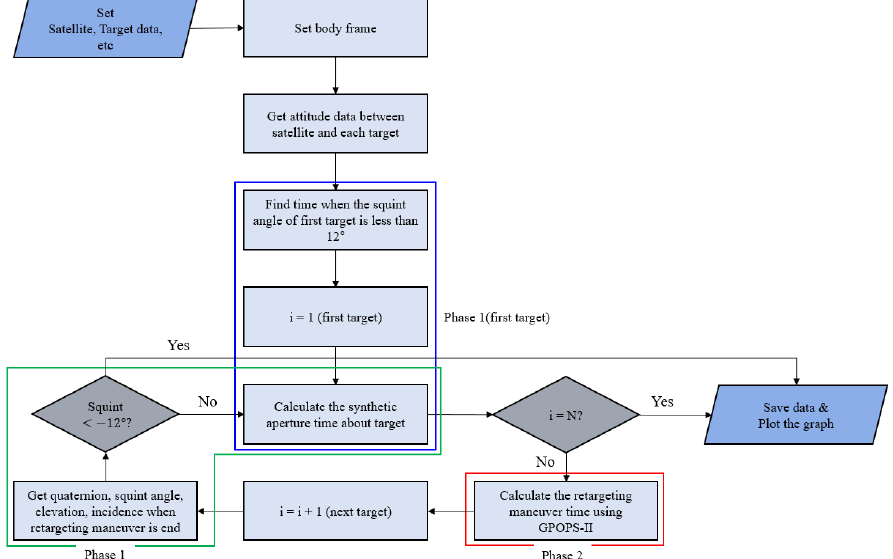
Figure 12. Flowchart for the image-taking of successive targets. First, target information (latitude and longitude), satellite coordinates, and